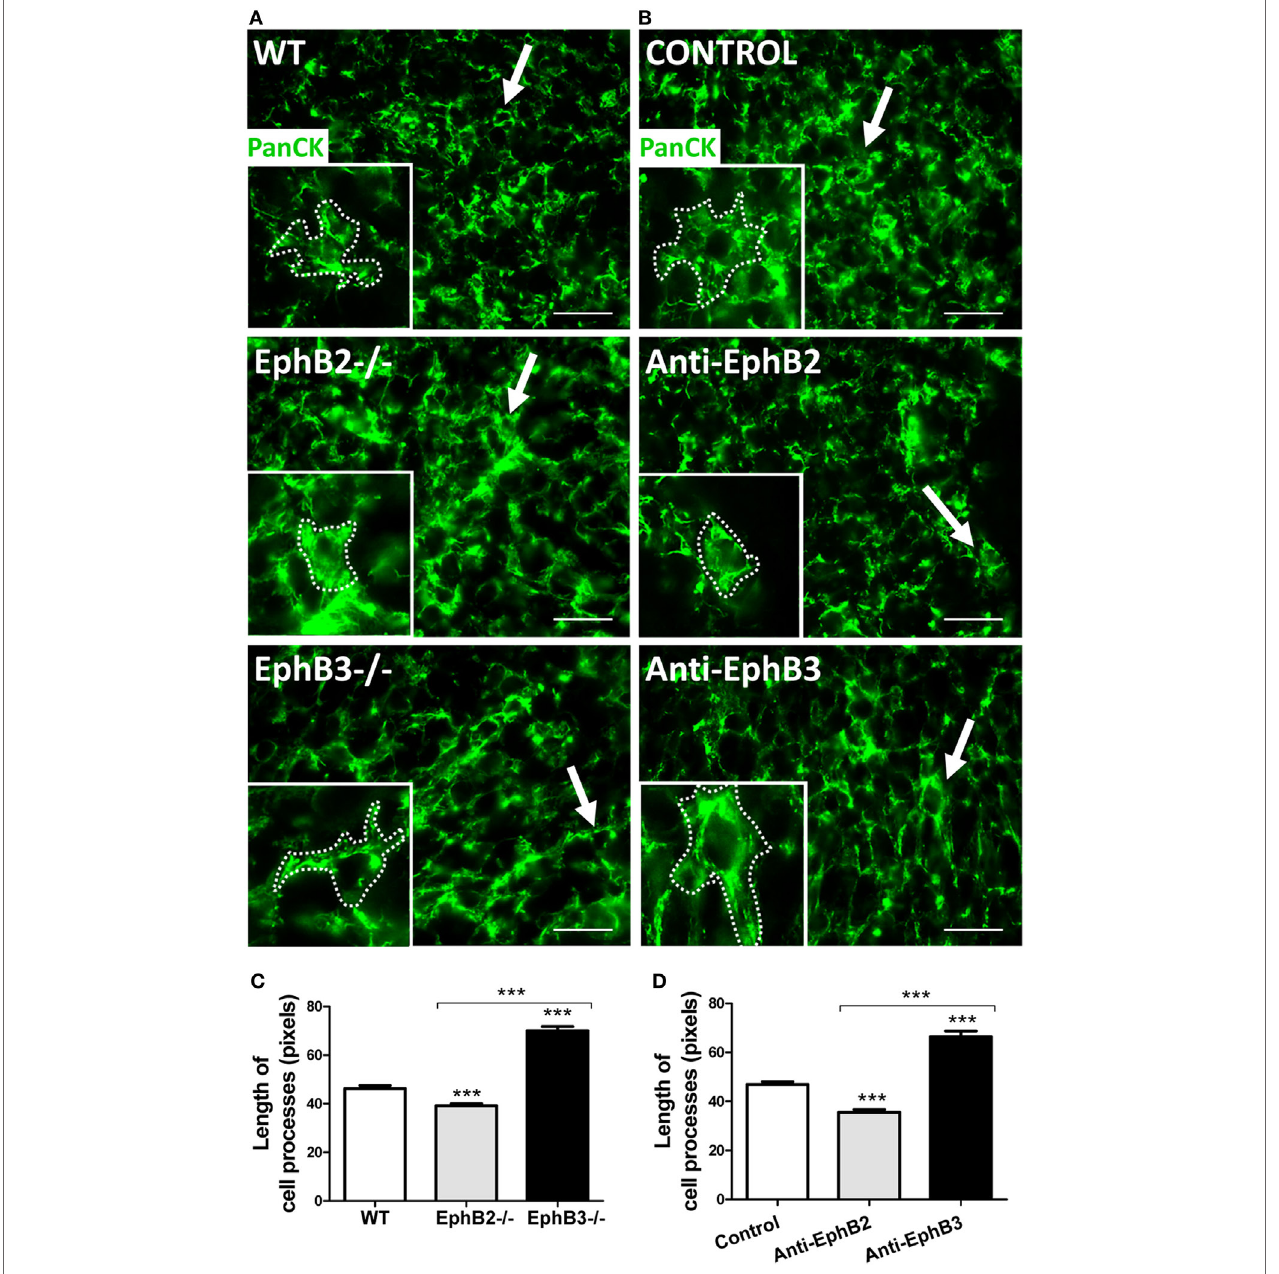
FigUre 1 | Thymic epithelial cell (TEC) morphology in reaggregate thymus organ cultures (RTOCs) established with either WT cells or EphB-deficient cells, or RTOCs treated with either blocking anti-EphB2 or anti-EphB3 antibodies. (A,B) Standard immunofluorescence study of the TEC network stained with an anti-PanCytokeratin antibody (PanCK, Green) and details of the TEC morphology in the different established RTOCs. Notice the shortened epithelial cell processes (arrows and insert dotted line) in RTOCs established with EphB2 − / − cells (A) or treated with a blocking anti-EphB2 antibody (B) and the elongated cell processes (arrows and insert dotted line) in RTOCs established with EphB3 − / − cells (A) or treated with anti-EphB3 antibody, as compared with their respective WT controls (A) or isotype control antibodies [ (B) , control]. The inserts illustrate the morphology of these cells. Scale: 50 µm. (c,D) Morphometric analysis of the length of cell processes in RTOCs established with either EphB2- or EphB3-deficient cells or RTOCs treated with blocking anti-EphB2 or anti-EphB3 antibodies. Note the reduced length of cell processes in RTOCs established with EphB2 − / − cells (c) or treated with anti-EphB2 antibody (D) , while those established with EphB3 − / − cells (c) or treated with anti-EphB3 antibody (D) show longer cell processes as compared with their control RTOCs. The length of cell processes was measured in pixels in those cells whose cell body appeared sectioned. Five RTOCs of each experimental group were studied measuring about 25 cells and a total of 100–150 cell processes by reaggregate. The significance of the Student’s t -test probability is indicated as *** p ≤ 0.005.